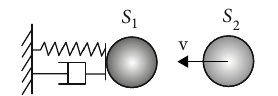
Figure 2: Schematic diagram of the contact of two